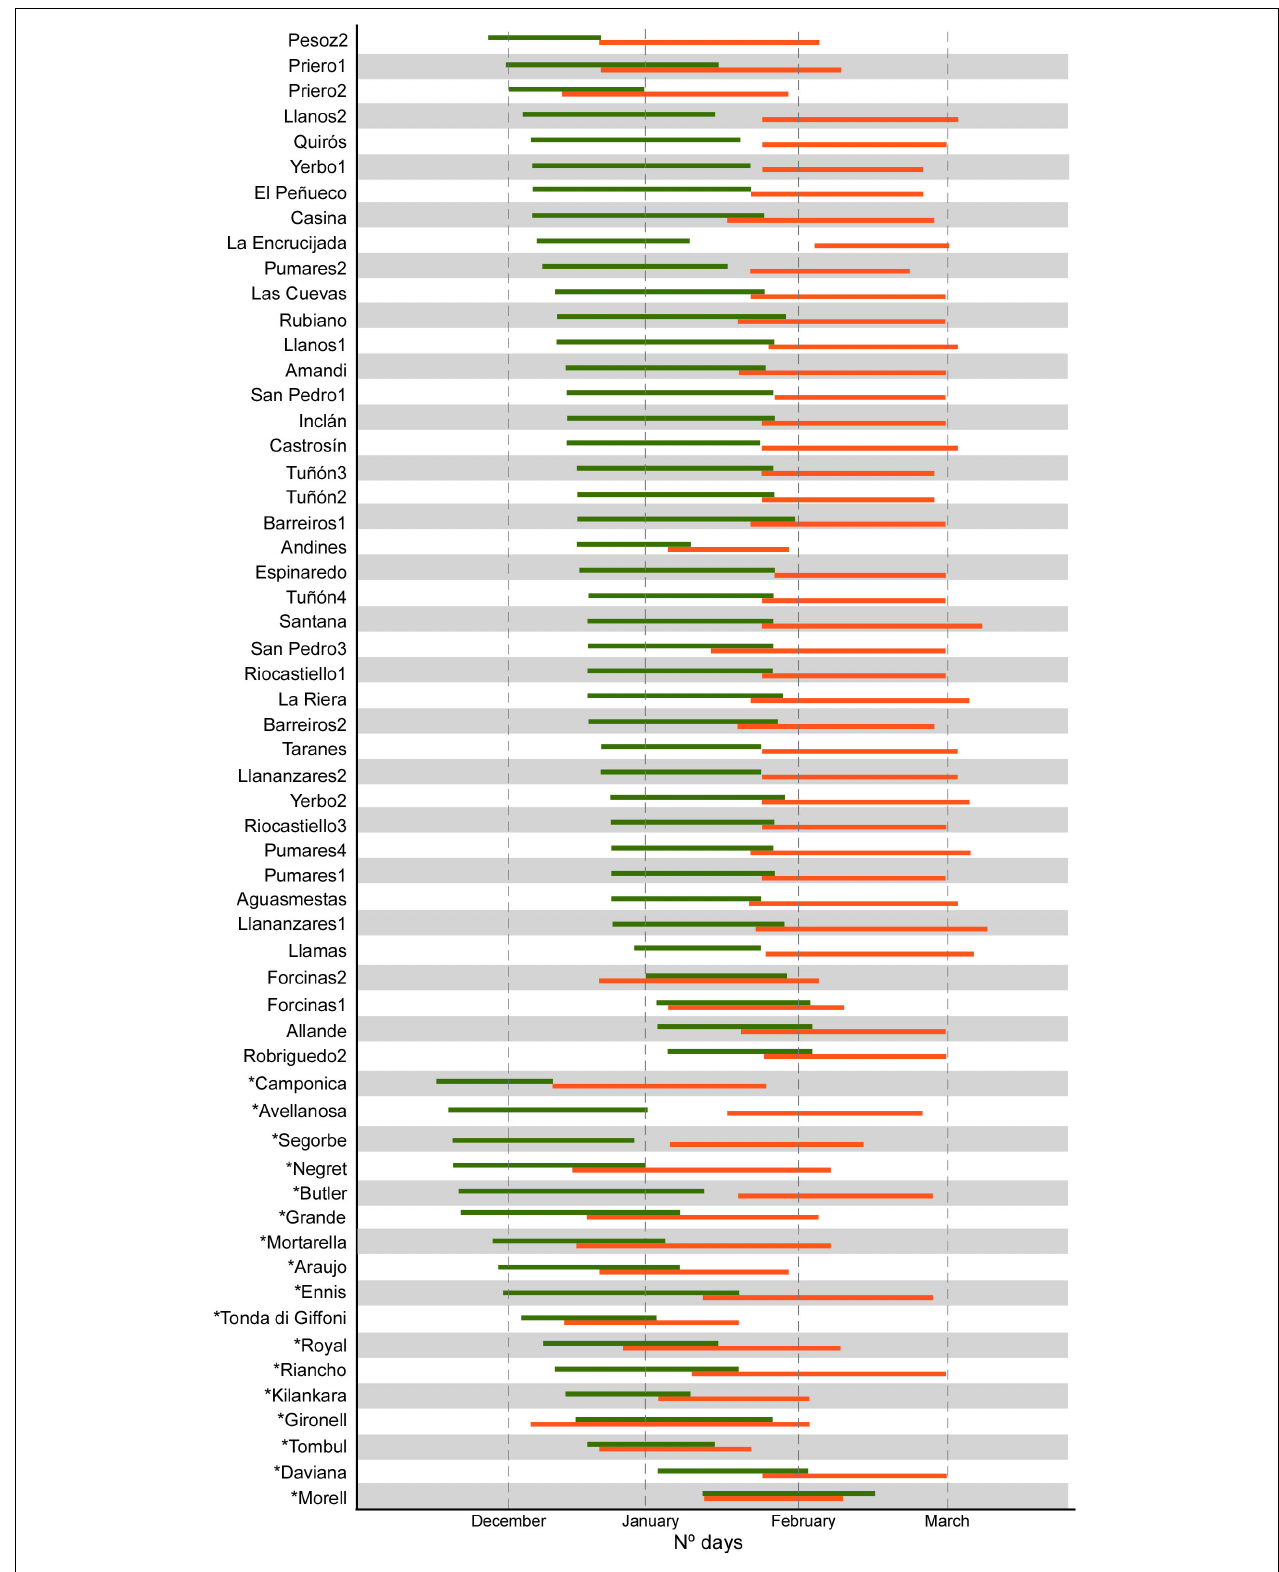
FIGURE 1 | Period of male (green) and female flowering (orange) of 58 hazelnut accessions at SERIDA in Villaviciosa, Spain. December 1 was taken as day one in the evaluation in each year.